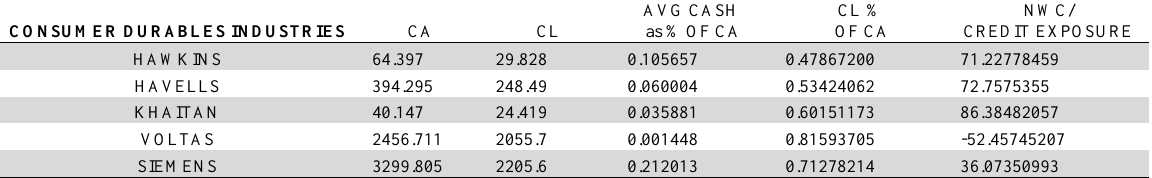
Analysis of Liquidity position of Consumer Durable Sector CONSUMER DURABLES